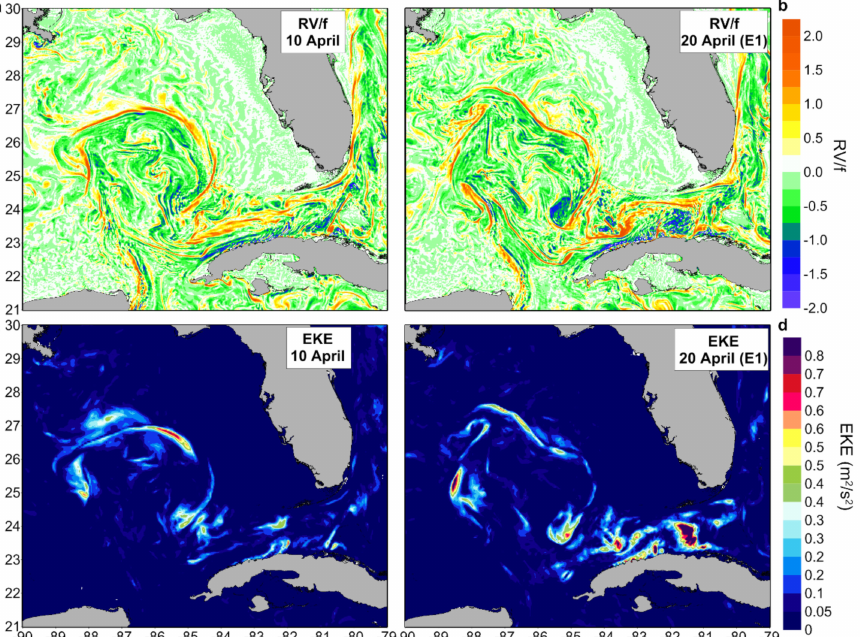
Figure 7. Relative Vorticity (RV), normalized with the Coriolis frequency (f), on ( a ) 10 April and ( b ) 20 April (E1) and eddy kinetic energy (EKE) on ( c ) 10 April and ( d ) 20 April (E1), computed by the surface current fields (GoM-HYCOM